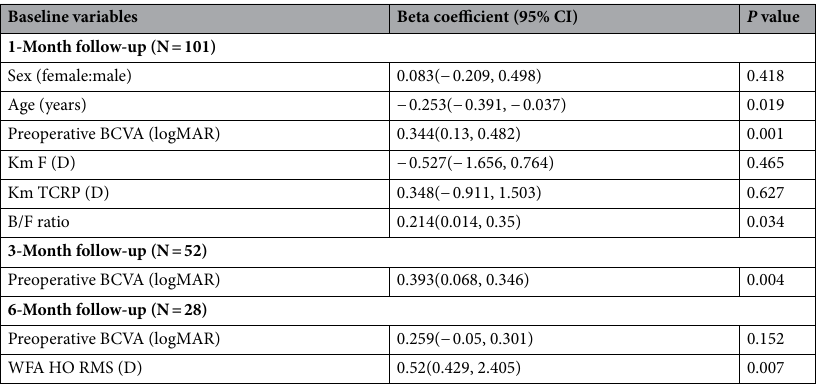
Table 4. Multivariate analysis of factors associated with BCVA of the post-operative MFS group. CI: confidence interval; BCVA: best-corrected visual acuity; Km: mean keratometry; F: front (anterior corneal surface); Astig: astigmatism; TCRP: total corneal refractive power; WFA HO RMS: root mean square of the total corneal high order aberrations calculated in the 4-mm zone around the corneal apex; B/F ratio: mean radius of the posterior corneal surface/mean radius of the anterior corneal surface